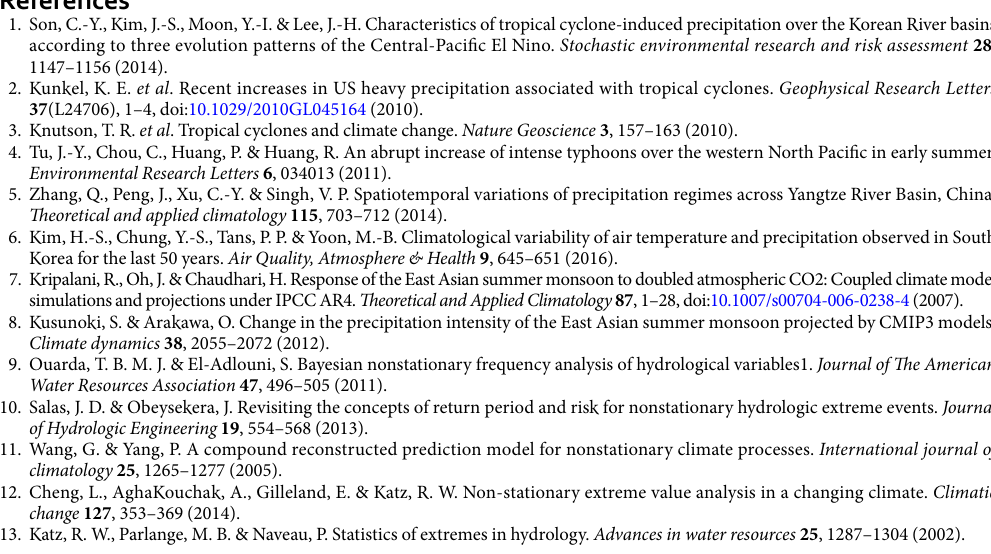
represented the